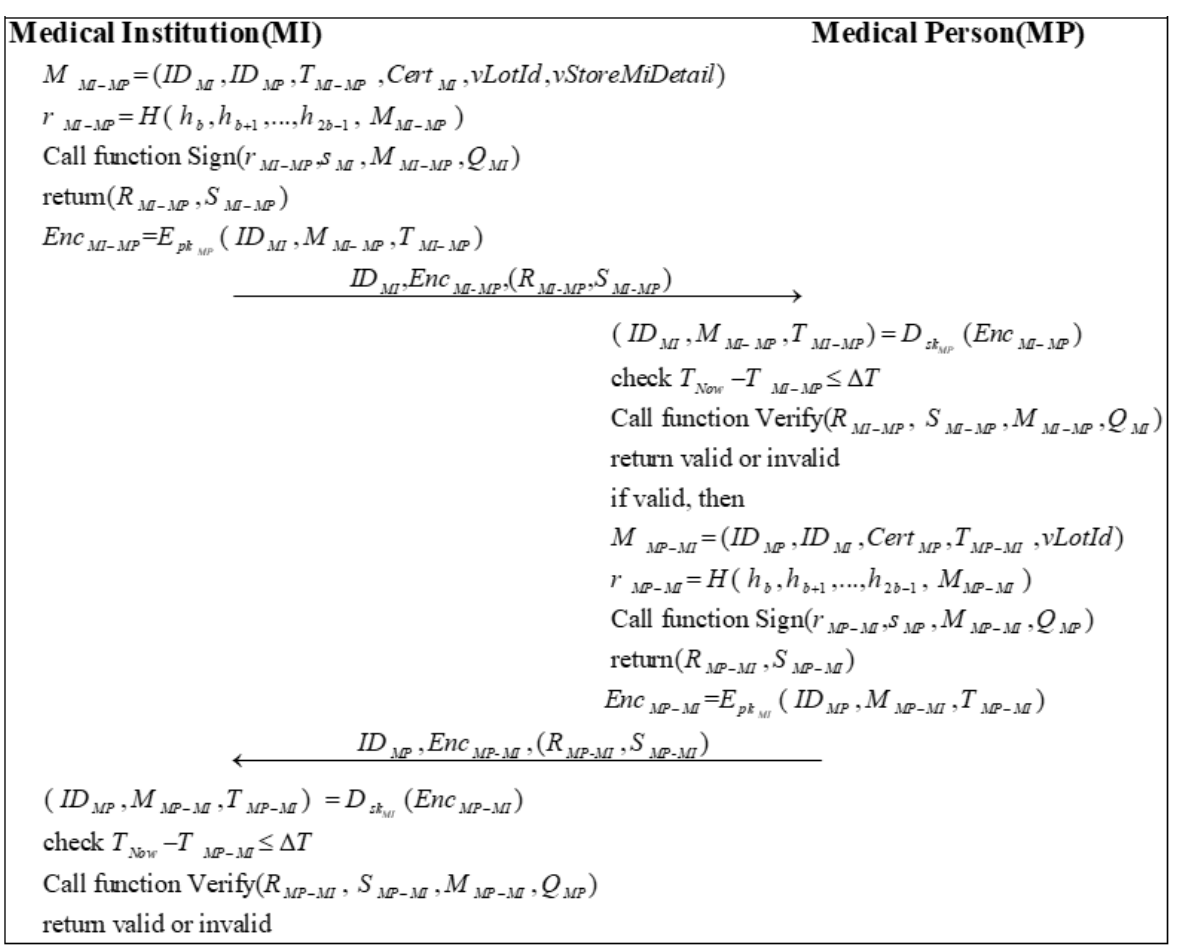
Figure 8. The process of vaccine distribution.